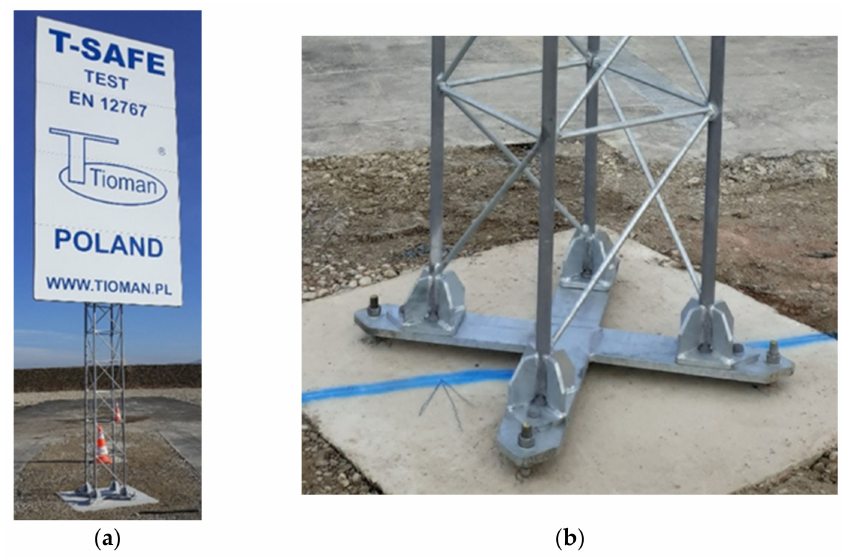
Figure 3. Supporting mast of the road sing.: ( a ) mast T03, ( b ) T03 mast base slab.